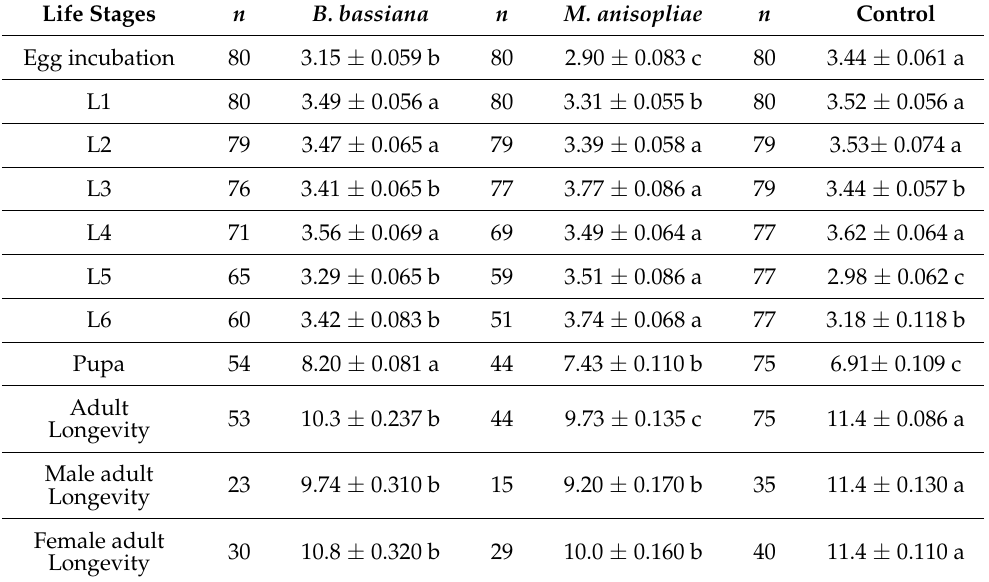
Table 1. Development period (average no. of days) of Spodoptera frugiperda fed on maize plants colonized with Beauveria bassiana and Metarhizium anisopliae in comparison with untreated plants. Life Stages n B. bassiana n M. anisopliae n Control Egg incubation